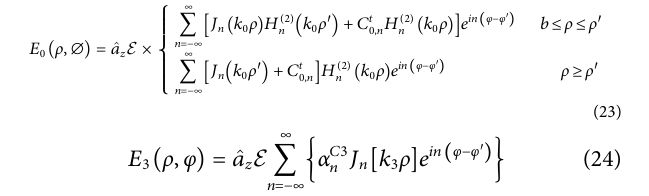
Frontiers in Materials |